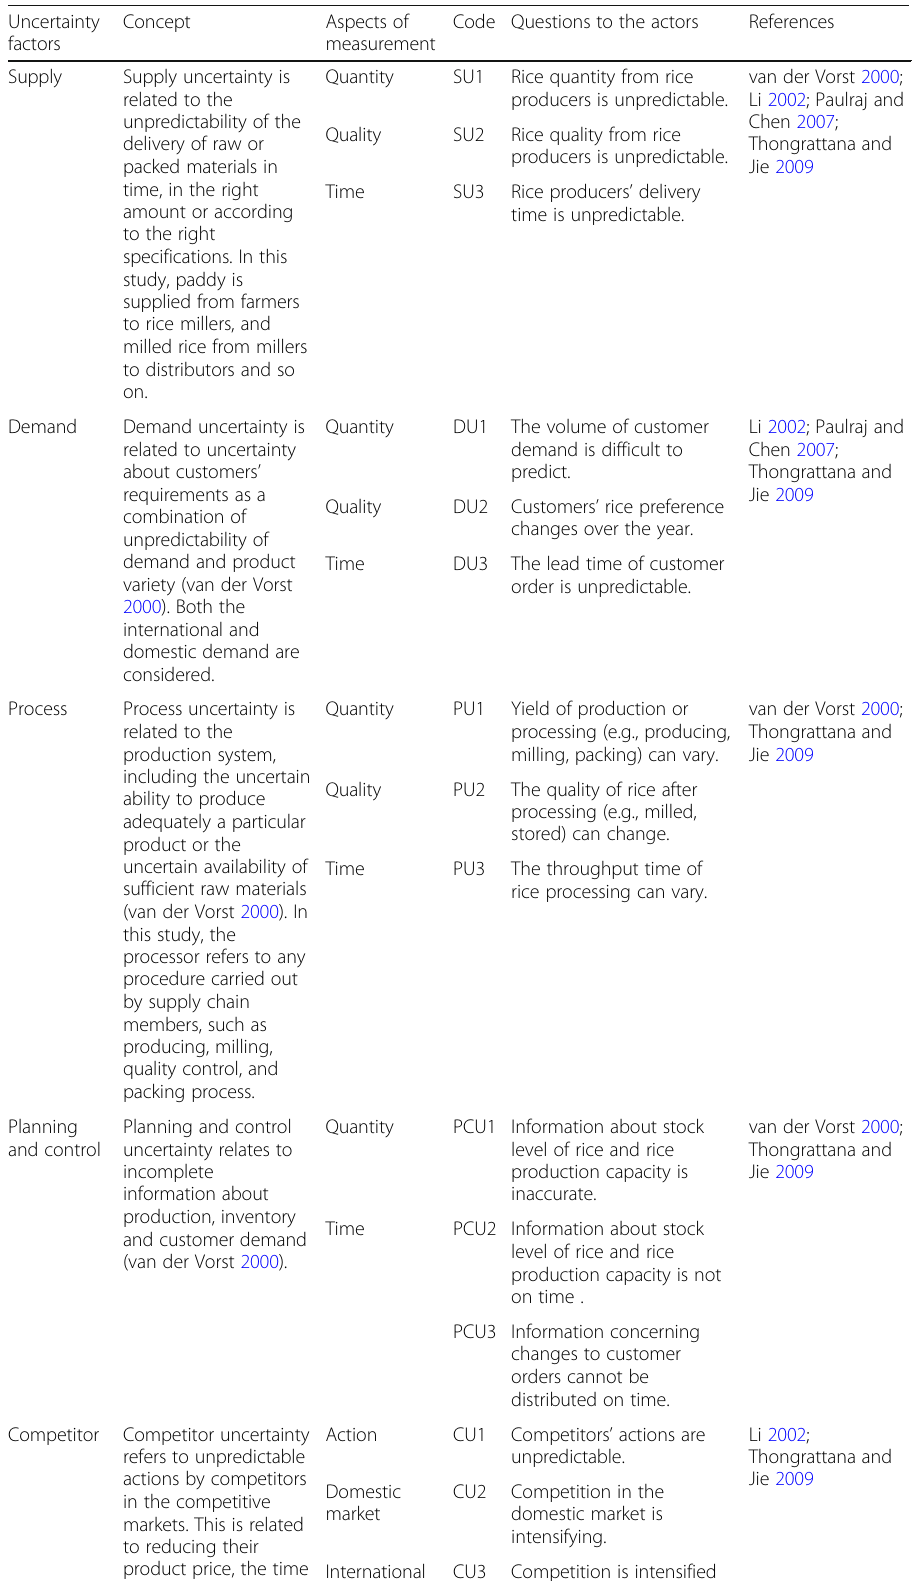
Table 3 Questionnaire items of uncertainty